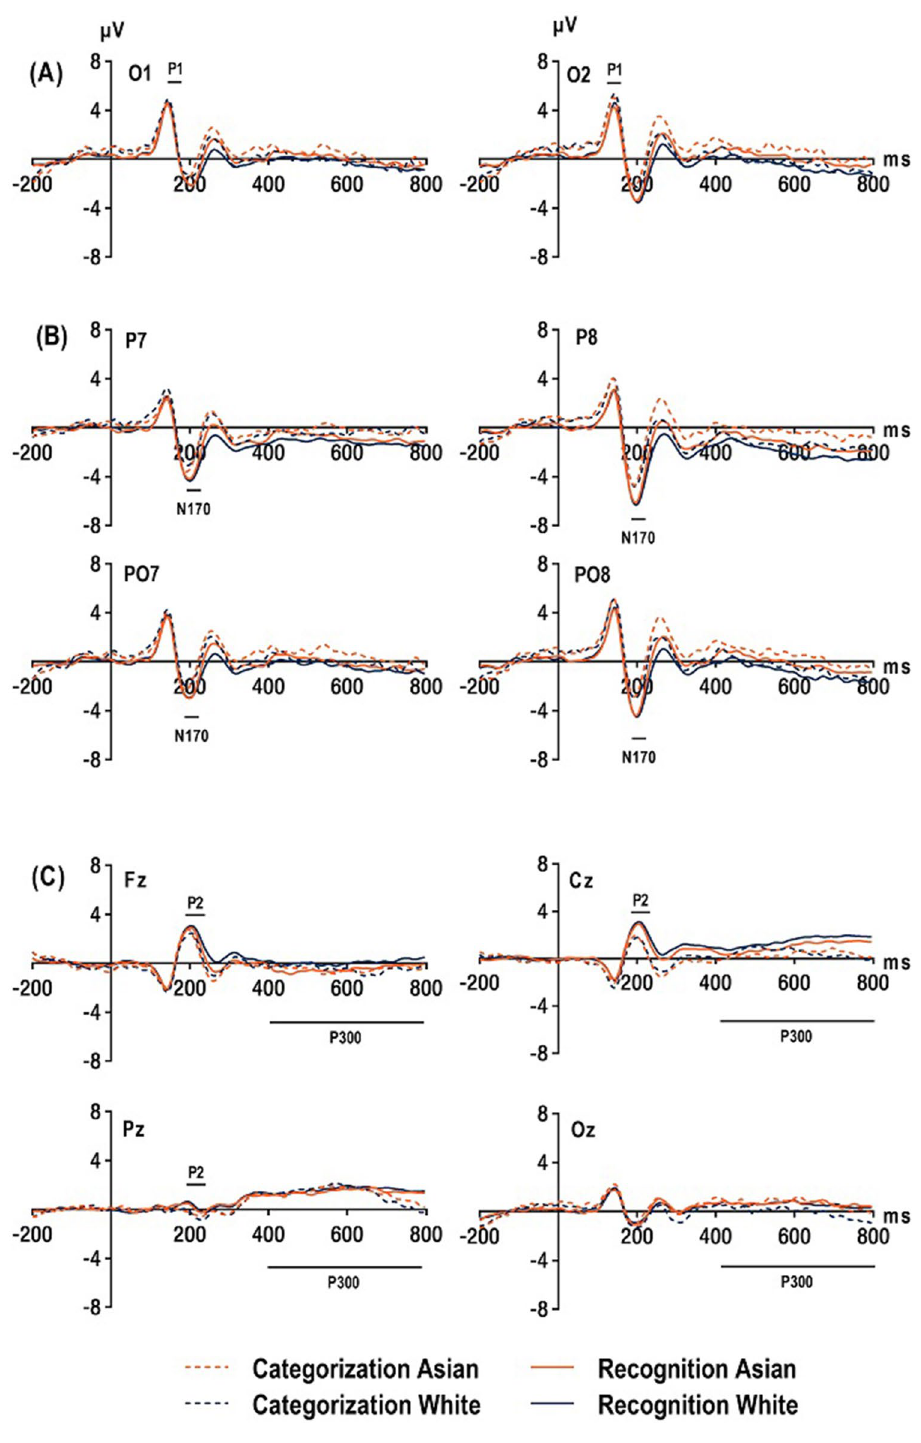
Figure 2. Grand average waveforms. ( A ) P1 at O1/O2 in the 120–160 ms time window, ( B ) N170 at P7/8 and PO7/8 in the 180–220 ms time window, ( C ) P2 at Fz/ Cz/ Pz in the 180–240 ms time window, P300 at Fz, Cz, Pz, Oz in the 400–800 ms time